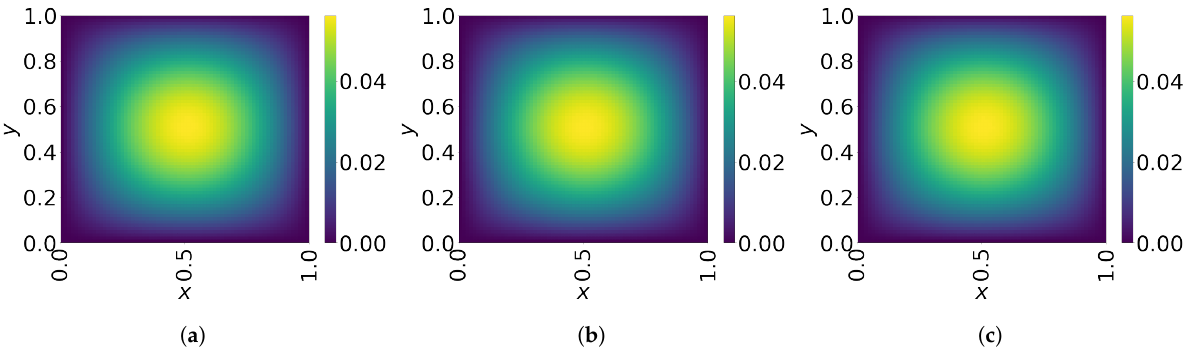
Figure 15. 2D linear convection diffusion equation. Solution snapshots of FOM, Galerkin ROM, and LSPG ROM at t = 1. ( a ): FOM, ( b ): Galerkin ROM, ( c ): LSPG ROM.